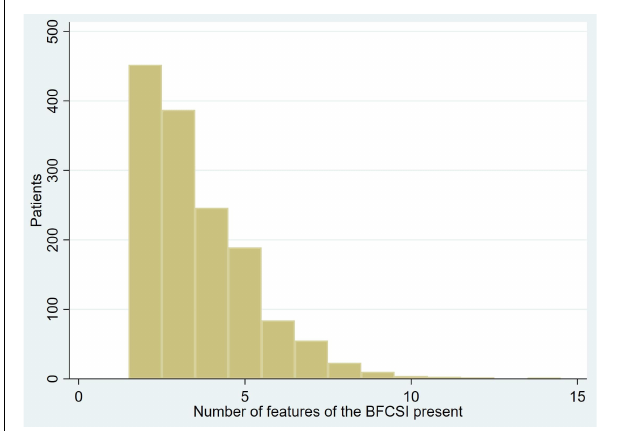
FIGURE 2 | Frequency of individual items of the Bush-Francis Catatonia Screening Instrument.